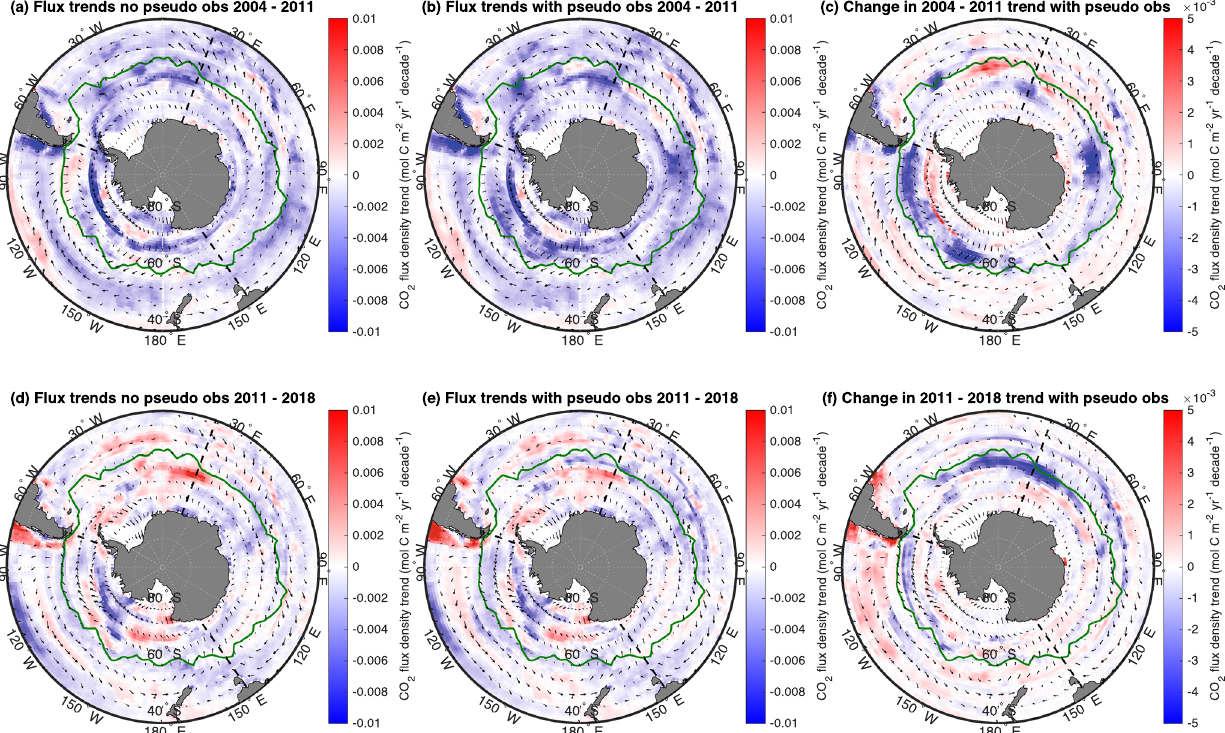
Fig. 4 Mapped CO 2 fl ux trends. Colours show air – sea CO 2 fl ux trends (negative is increasing uptake) and arrows show wind trends, for the 2004 – 2011 period (top row) and 2011 – 2018 period (bottom row). Values are moles of carbon per metre squared per year per decade (molCm − 2 yr − 1 decade − 1 ). Panels a and d show CO 2 fl ux trends when pseudo observations are not used, panels b and e show the trends when the pseudo observations are included, and panels c and f show the difference in CO 2 fl ux trends due to the pseudo observations (note the different colour scale for the difference plots). The solid green line on all panels shows the latitude of the 2004 – 2018 mean zonal wind maximum based on CCMP winds 46 , and the black dashed lines mark ocean basin